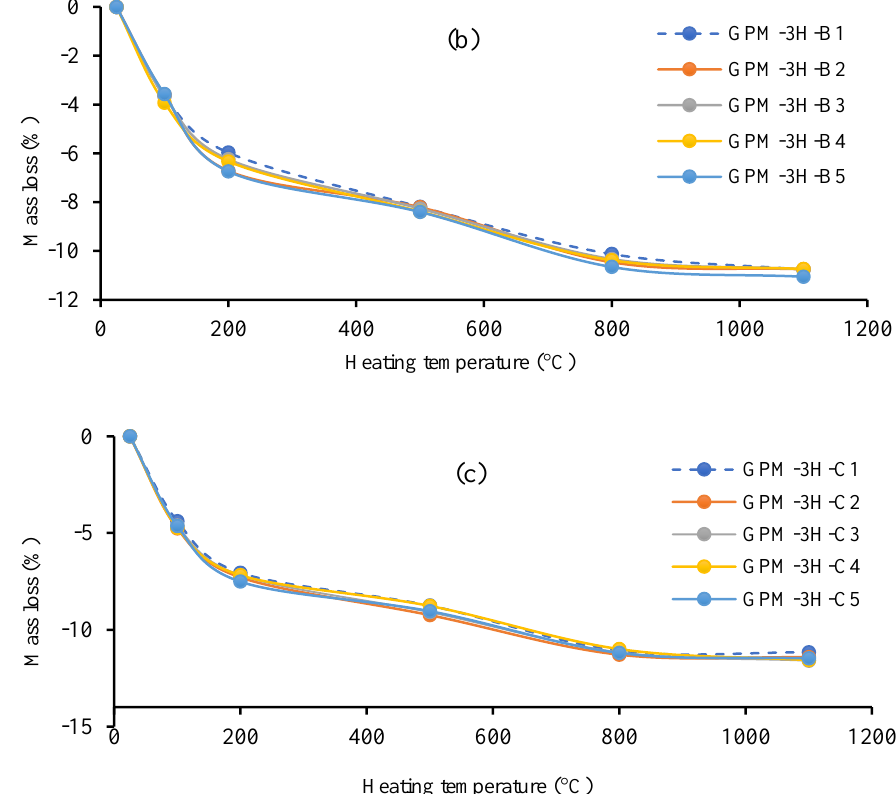
Figure 21. Mass loss (%) vs. elevated temperature for the geopolymer paste using various Na 2 SiO 3 - to-NaOH and FA-to-GGBS ratios with sand preheated at 110 ◦ C: ( a ) Series A geopolymer paste; (b) Series B geopolymer paste; ( c ) Series C geopolymer paste.